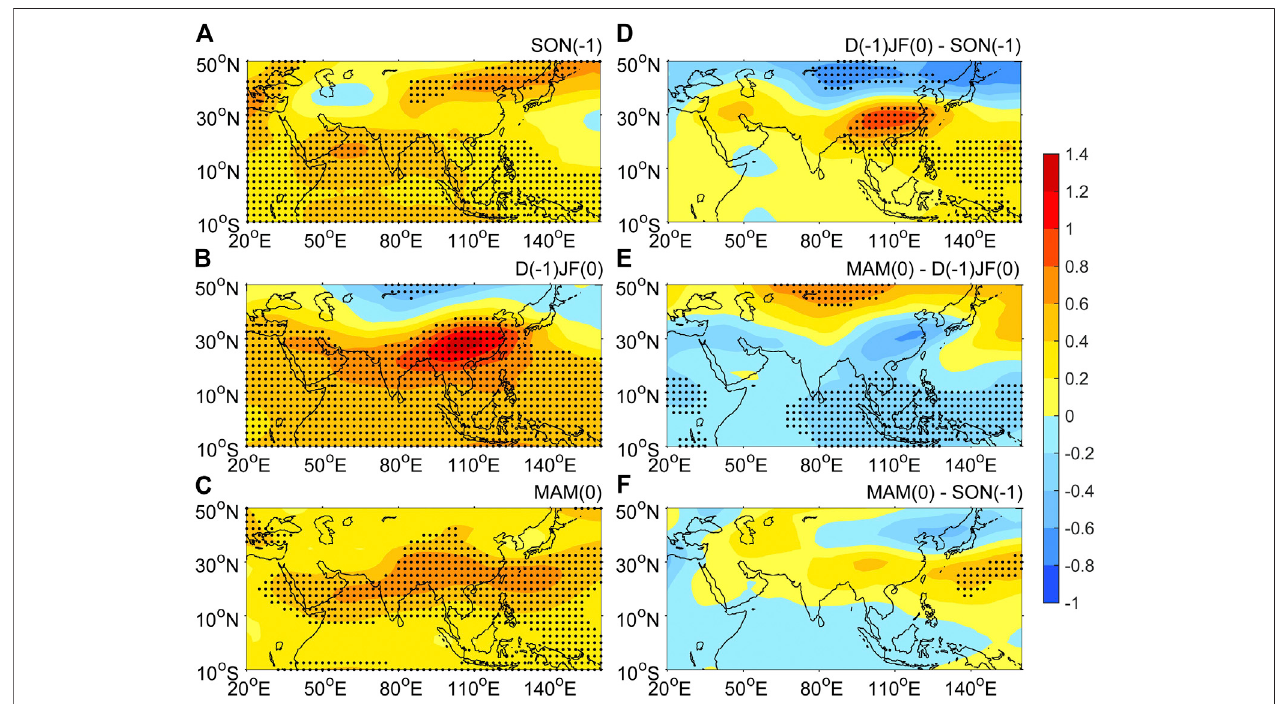
FIGURE5| Epochaldifferences(K)oftheseasonalmeantemperature (leftpanel) andtheinter-seasonalchangeoftemperature (rightpanel) inthe500 – 200 hPa layer. Left panel: (A) autumn (SON( − 1)), (B) winter (DJF(0)), (C) spring (MAM(0)); right panel: (D) winter minus autumn, (E) spring minus winter, (F) spring minus autumn.Label “ − 1 ” denotes(1993 – 2016)minus(1979 – 1992),and “ 0 ” denotes(1994 – 2017)minus(1980 – 1993).Thestippledareasdenotethedifferencessigni fi cantat the 95% con fi dence level.